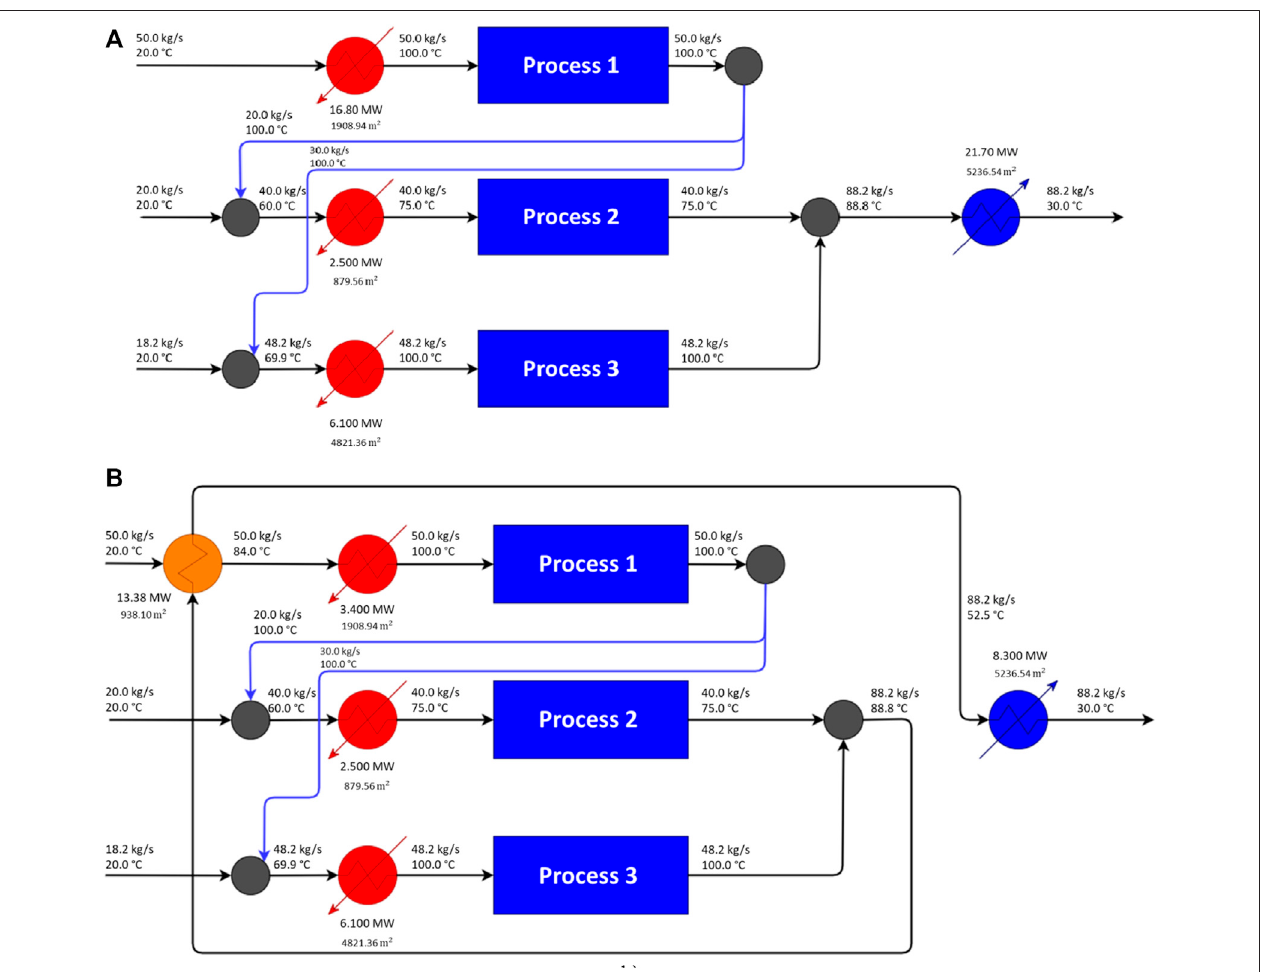
FIGURE 4 | Flowsheet for (A) WEN con fi guration obtained by the implementation of the MINLP model (WEN1), (B) WEN con fi guration obtained by further heat integration (WEN2).